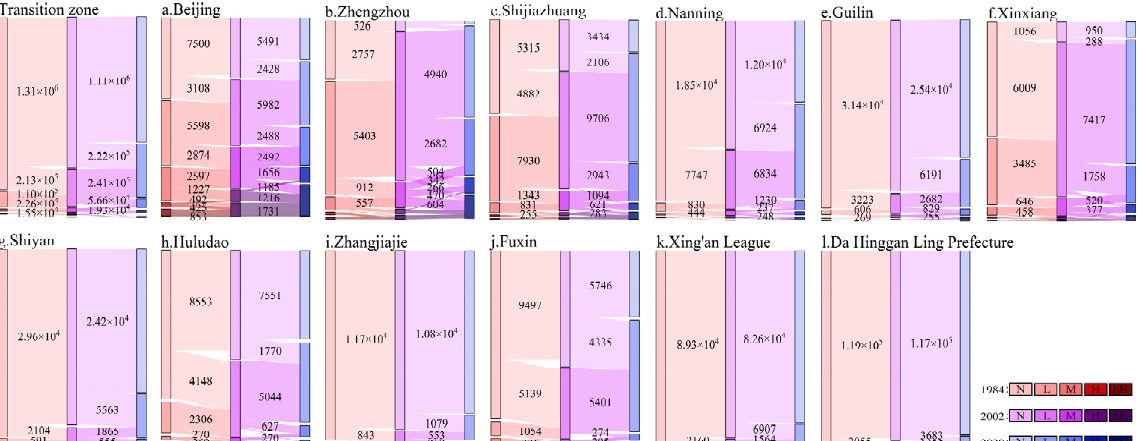
Figure 10. Transitions of different nighttime lighting types in the whole region and different tier cities between 1984, 2002, and 2020. N, none; L, low; M, medium; H, high; EH, extremely high. Notes: The numbers of conversion pixels less than 10,000 in the transition zone and the number of conversion pixels less than 250 in different typical cities were not marked.